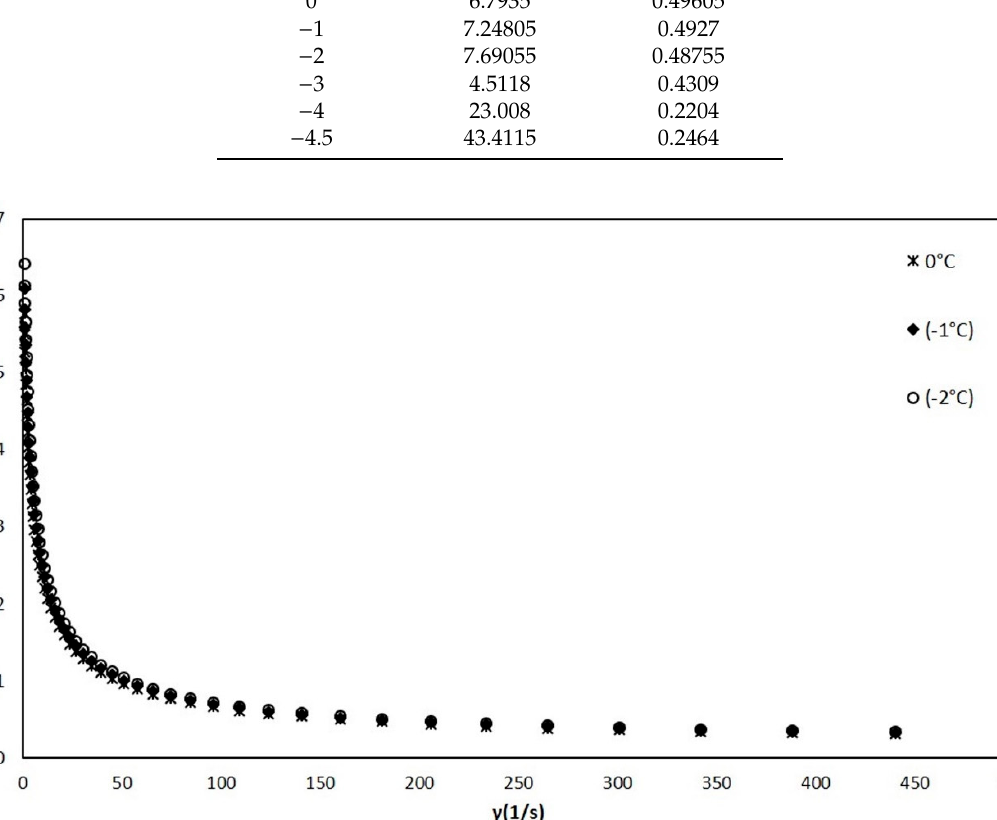
Table 1. Values of k and n for the ice cream mixture at different temperatures.